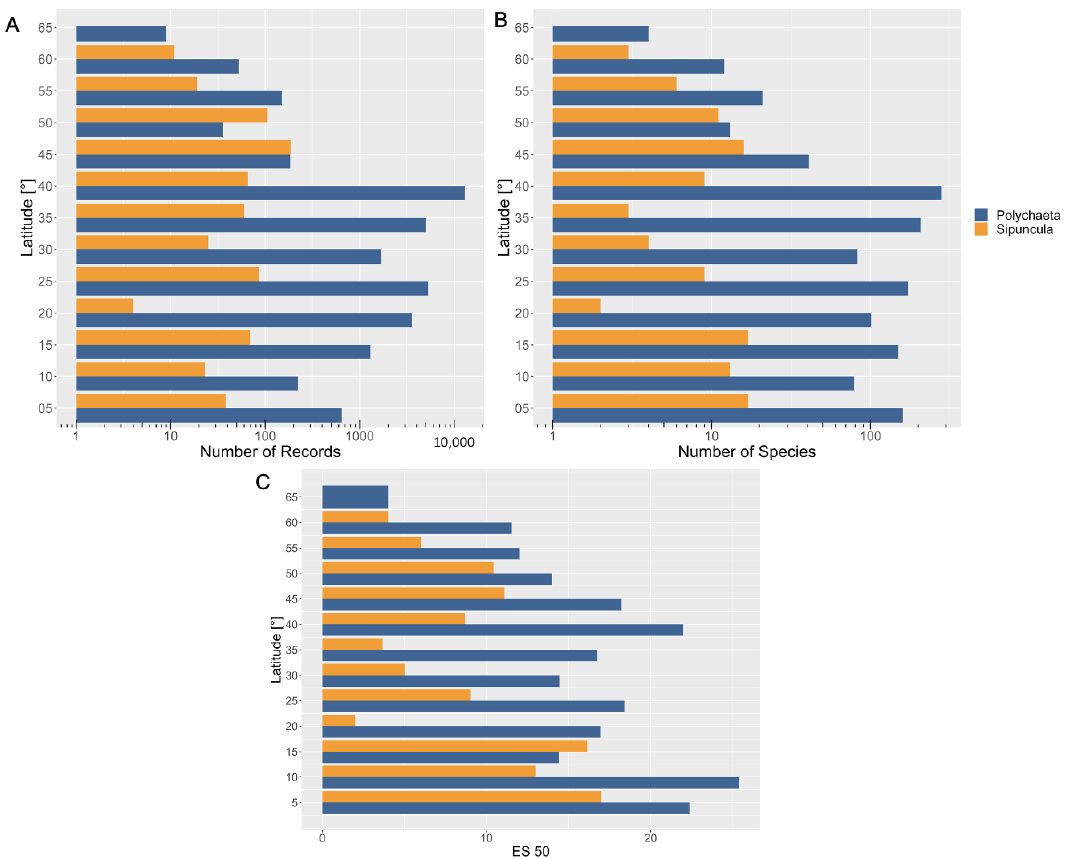
Figure 3. ( A ) Sampling effort (number of distribution records), ( B ) gamma species richness (number of species) and ( C ) ES50 (estimated species richness) for both Polychaeta and Sipuncula per 5° latitudinal band in the Northwest Pacific. The x-axes in ( A , B ) are logarithmic. records in the deep water (also at 40°), with almost 800 records, followed by the order Phyllodocida, with 300 records at latitude 25° (Figure S4B). The polychaete orders Amphinomida and Echiuroidea had the most occurrence rec- ords at 20° and 40°, respectively, while being the least abundant orders in our analysis (Figures 2A and 4). In comparison, the other polychaete orders Eunicida, Phyllodocida, Sabellida, Scolecida, Spionida and Terebellida had two peaks in occurrence records at around 20° and 40° latitude (Figure 4).